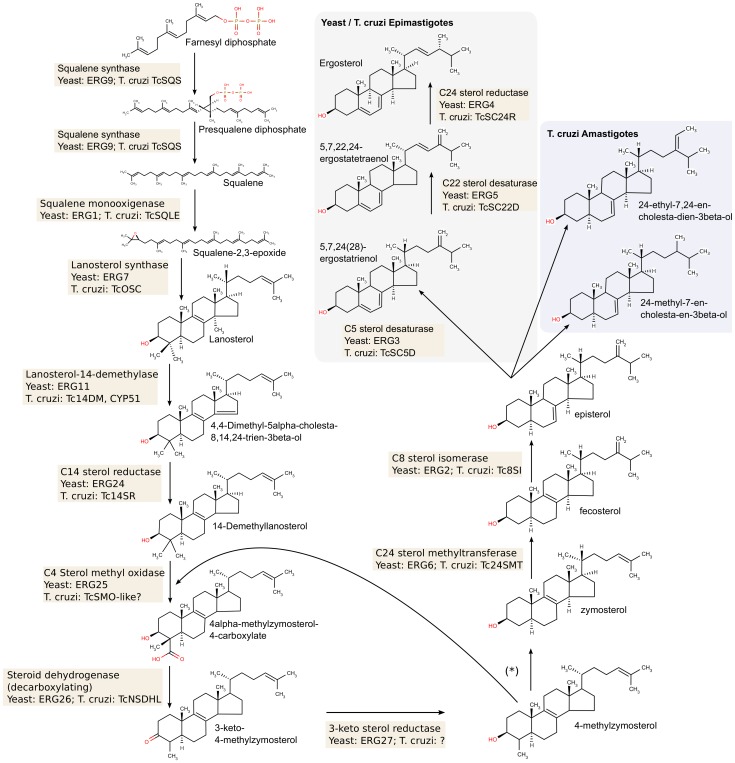
The T. cruzi sterol biosynthesis pathway.The figure shows the metabolic steps leading from farnesyl-diphosphate to ergosterol (in yeast, and in T. cruzi epimastigotes) or to different 24-alkylsterols (in T. cruzi amastigotes [64]), and the corresponding yeast and T. cruzi enzymes that catalyze these steps. The two methyl groups at C4 are removed in two rounds of successive C4-oxidation, C4-decarboxylation and C3-ketoreduction (*). Gene names used are those in Tables 1 and 2. Unknown/hypothetical assignments are shown with question marks.